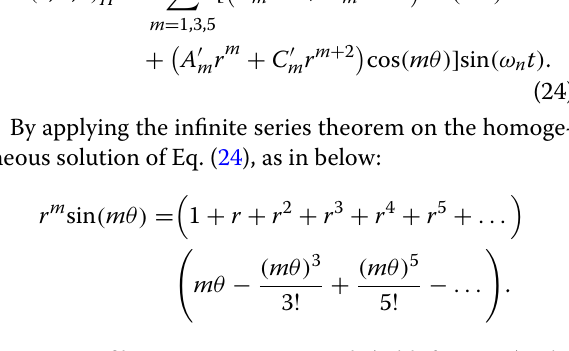
Figure 18 Stress analysis when the follower located at 270° with the